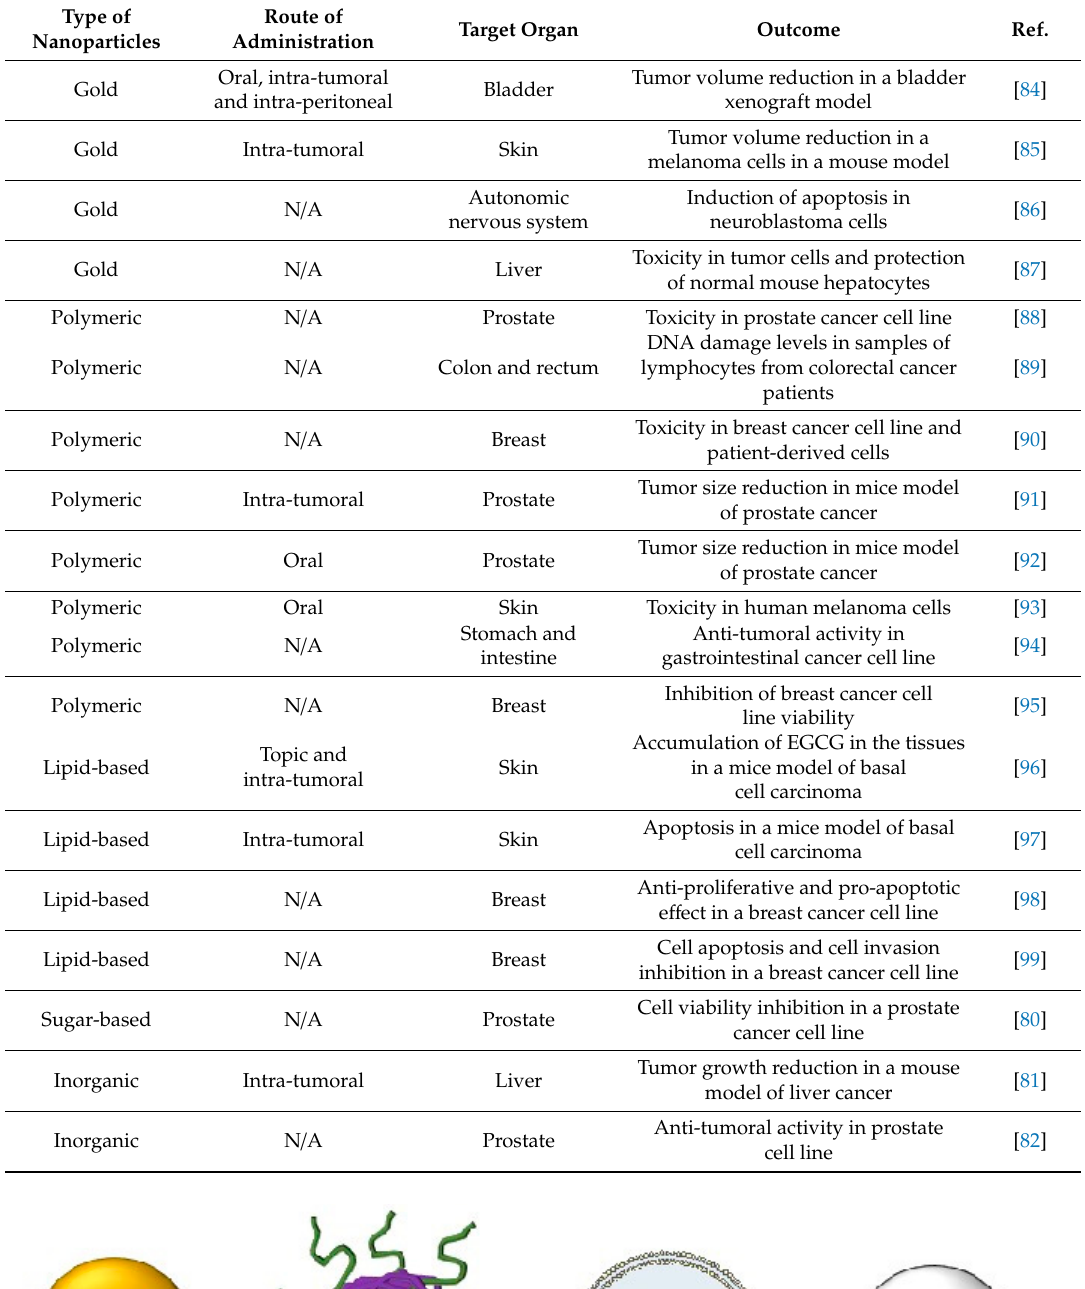
Table 1. Di ff erent types of EGCG nanocarriers for cancer management.